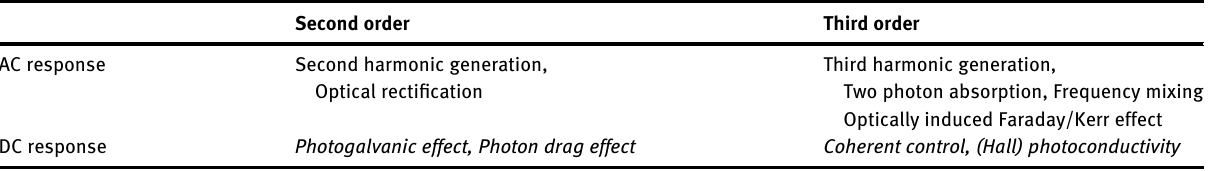
Table  : Summary of second and third-order light-driven